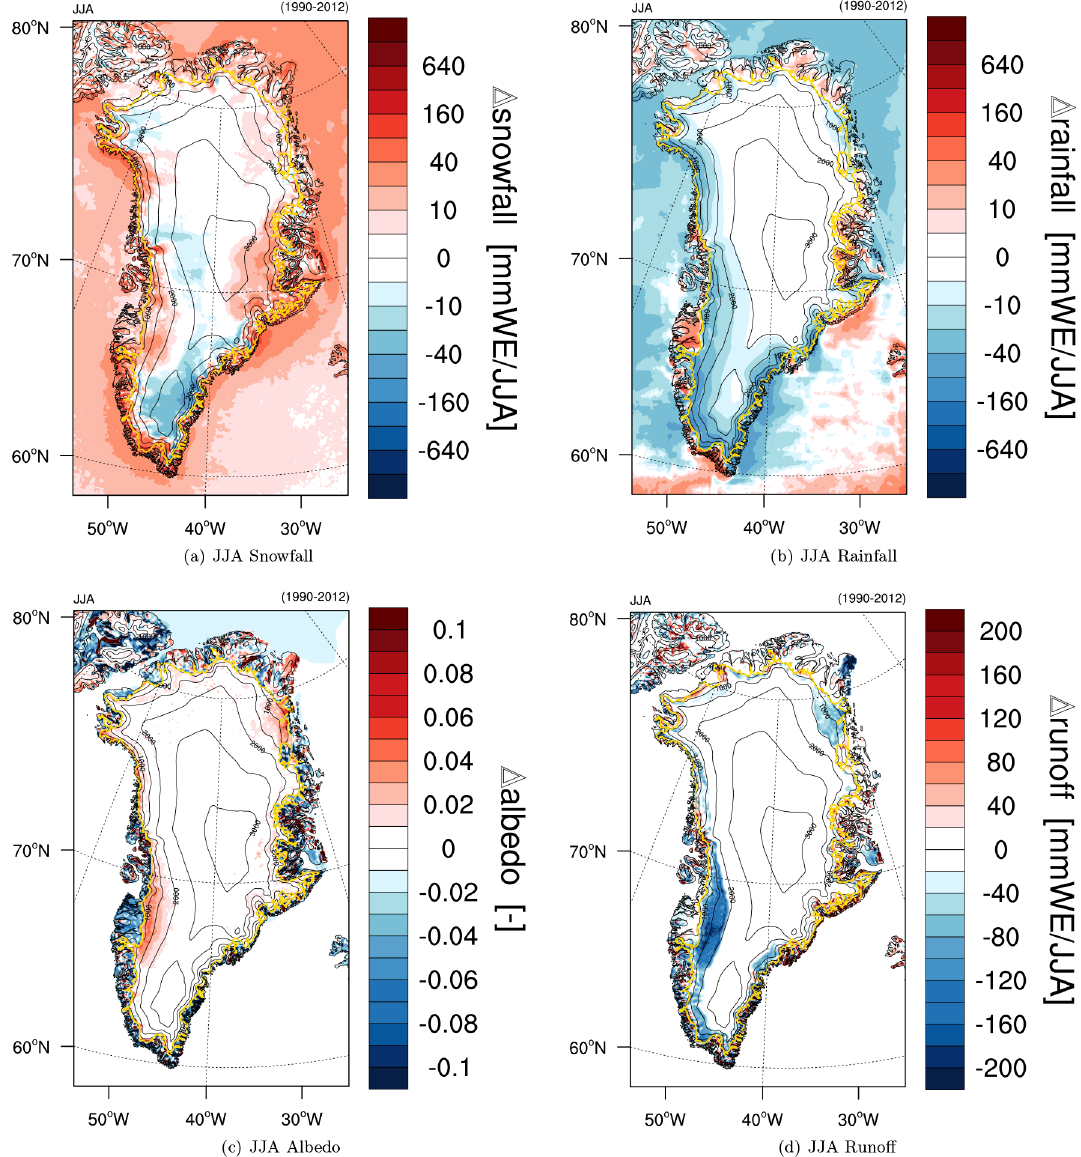
Figure 4. Change in JJA mean (a) snowfall (mmWEJJA − 1 ), (b) rainfall (mmWEJJA − 1 ), (c) surface albedo and (d) runoff (mmWEJJA − 1 ) between RACMO2.3 and RACMO2.1